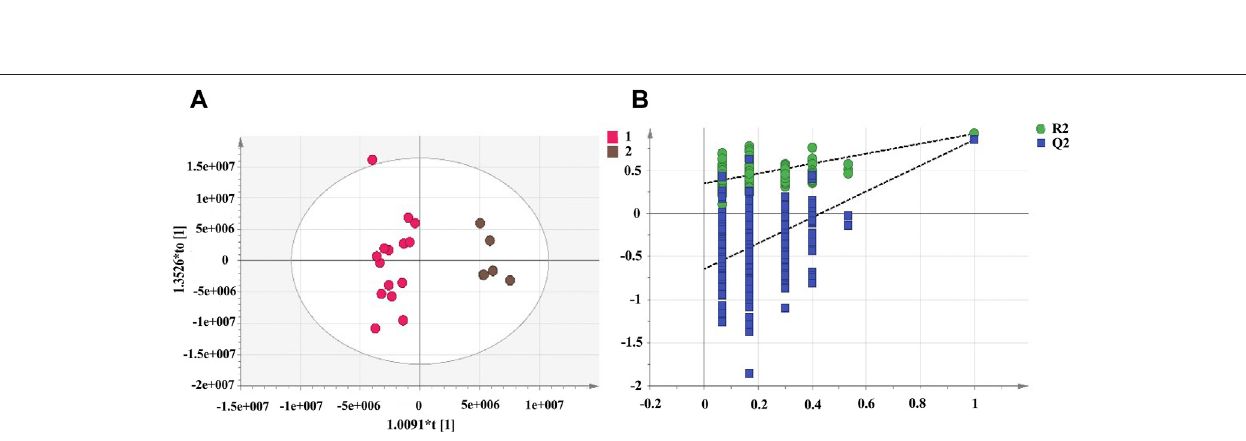
FIGURE 5| The score plots of OPLS-DA model for raw Reynoutria multi fl ora (RRM) and processed Reynoutria multi fl ora (PRM) analysis. R2Y and Q2 values of the OPLS-DA model are 0.925, 0.856, respectively. ( (A) : Left: RRM, PRM for 4, 8, 12, and 18 h; right: PRM for 24 and 32 h.) (B) : cross-validation plot of OPLS-DA model with 200 permutation